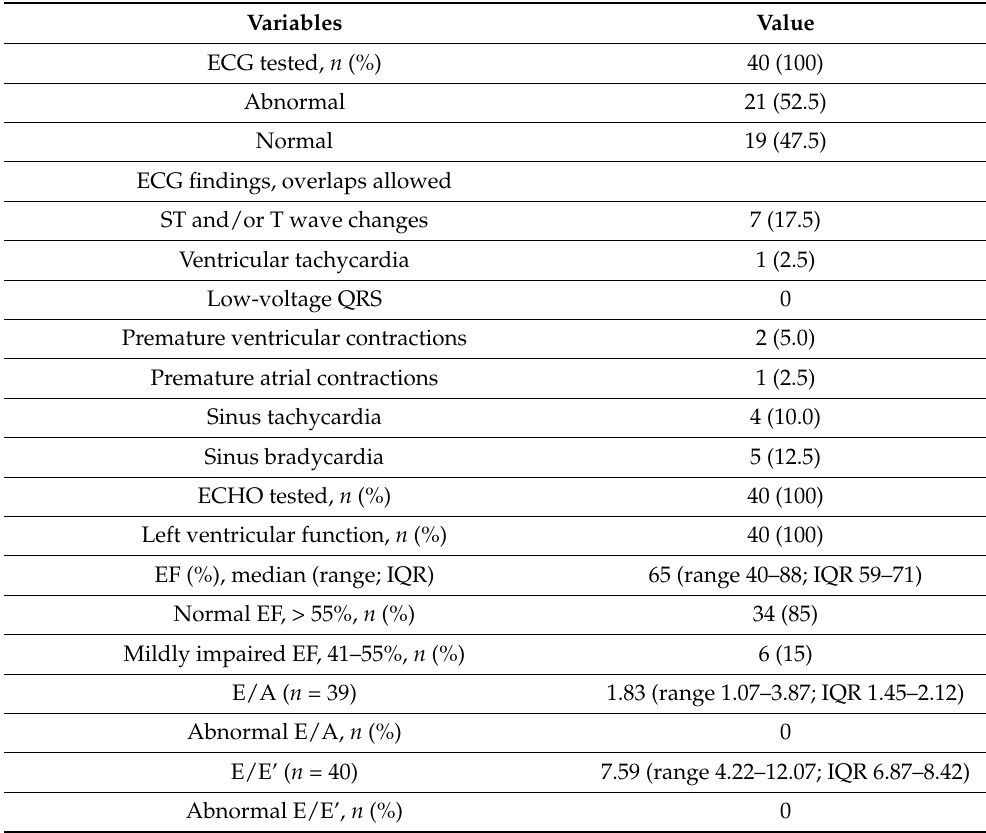
Table 3. Electrocardiographic and echocardiographic data of adolescents with chest pain and sus- pected myocarditis related to COVID-19